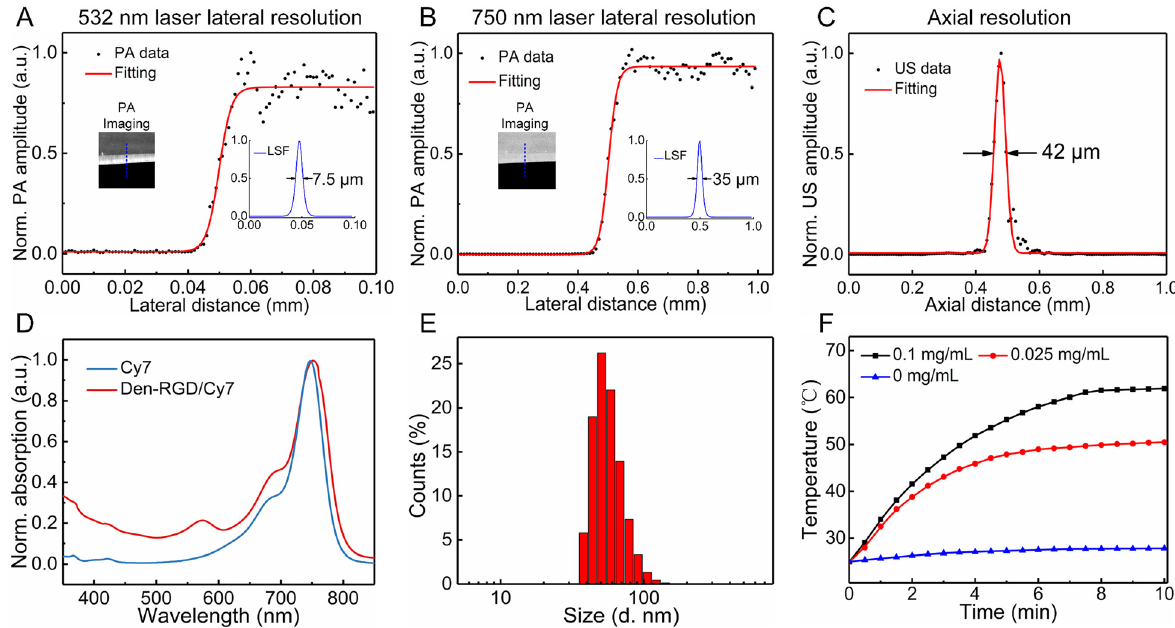
Figure 2: The imaging parameters of the PA system and the characterizations of the nanoparticles. (A) The lateral resolution of the 532 nm laser imaging system. (B) The lateral resolution of the 750 nm laser imaging system. (C) The axial resolution of the 532 and 750 nm laser imaging system. (D) UV – vis spectra of Cy7 and Den-RGD/Cy7, respectively. (E) DLS data of the nanoparticles dispersions. (F) Photothermaleffect of 0 mg/mL,0.025 mg/mL, 0.1 mg/mL Den-RGD/Cy7 nanoparticles underirradiation with a 750 nm laser (1 W/cm 2